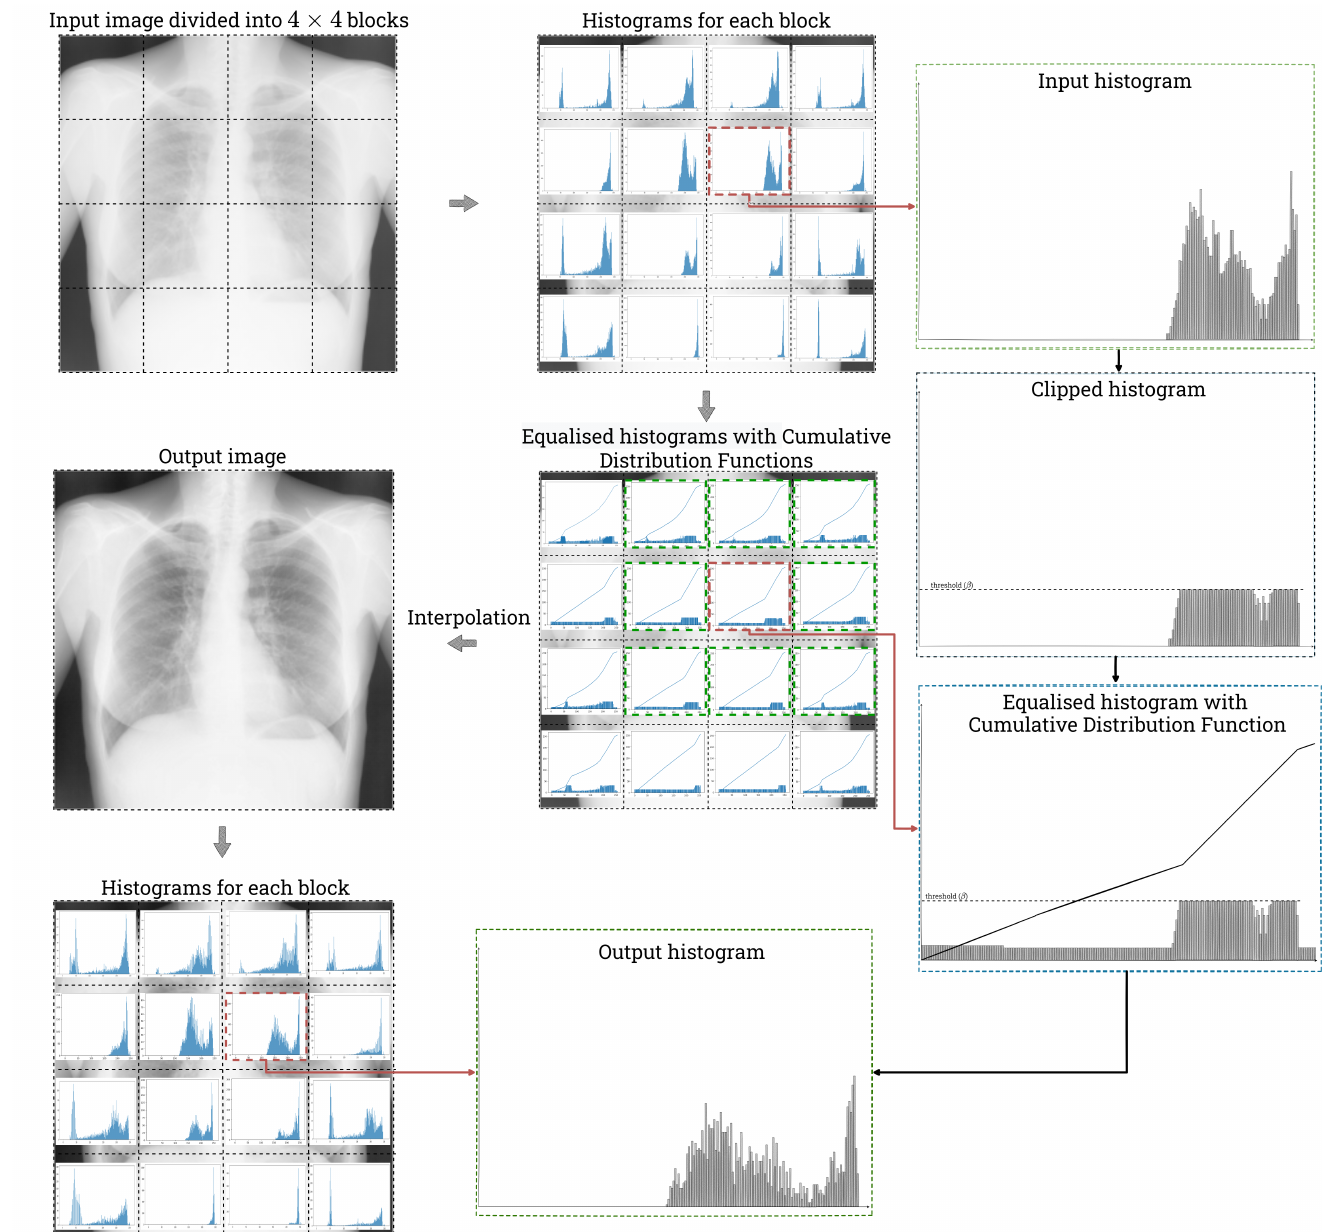
Figure 2. Overview of the CLAHE algorithm. First, the input image is divided into rectangular, non- overlapping windows (blocks, tiles). Second, for each of the tiles, a clipped histogram is computed. The excess is then redistributed and the cumulative distribution function (CDF) is computed. Finally, by using the CFD as the mapping function and interpolating the pixel values, the new image is obtained. Note that for each tile, the histograms are more